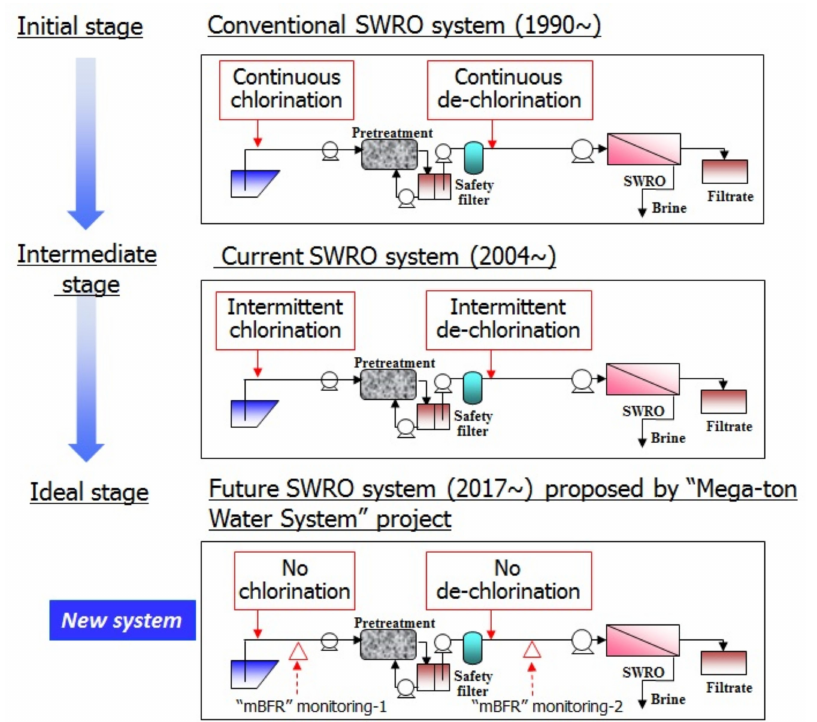
Figure 18. History of anti-biofouling trials and new system for future SWRO system